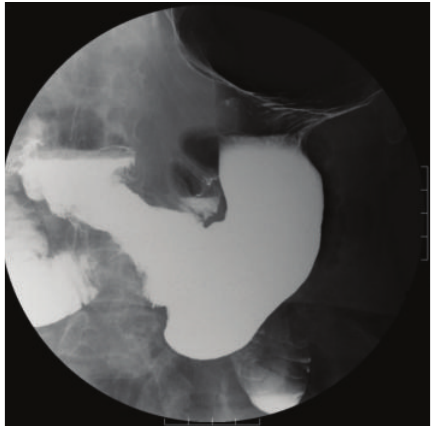
Figure 4: Fluoroscopy of the upper gastrointestinal tract. The huge tumor, 10cm in diameter, was located in the antrum of